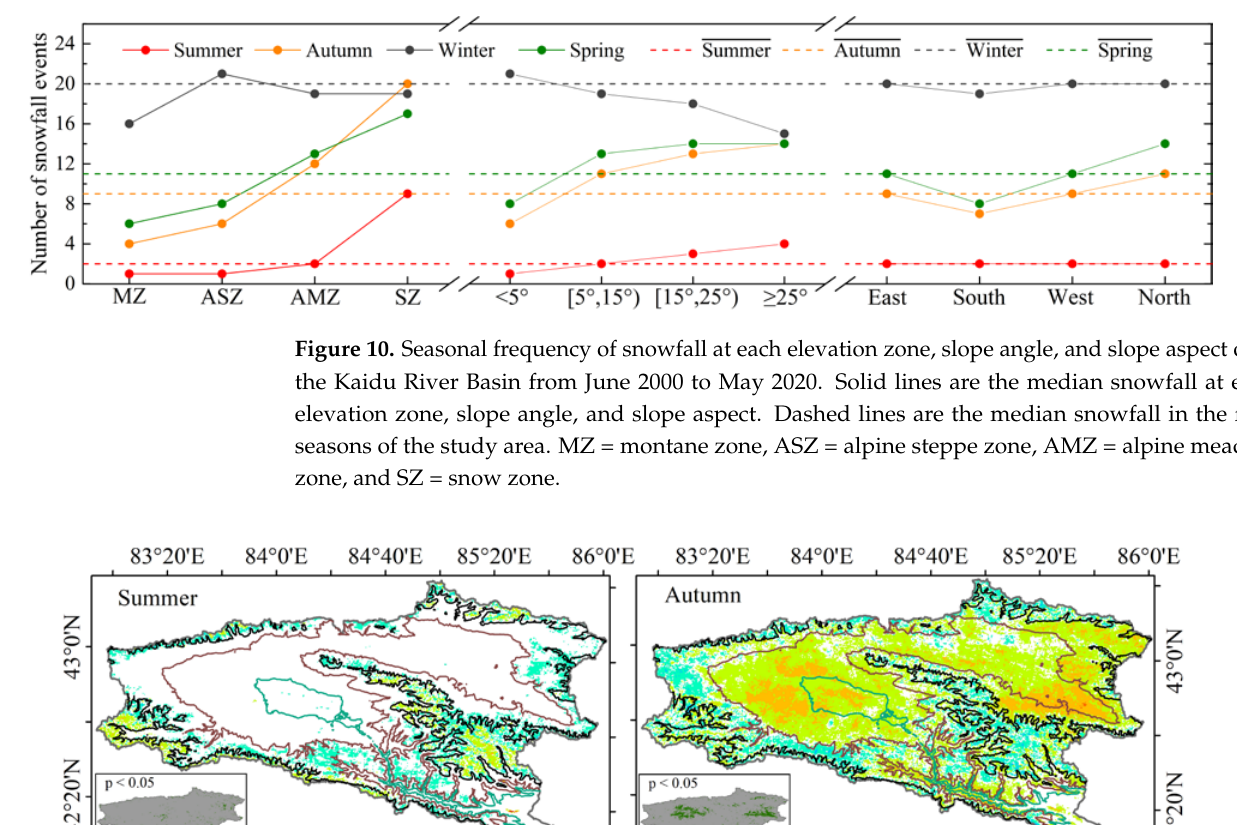
Figure 9. Spatial distribution of the seasonal median frequency of snowfall over the Kaidu River Basin from June 2000 to May 2020. SCA = snow-covered area, Mean = the mean value of the median snowfall frequency, and SD = the standard deviation of the median snowfall frequency.